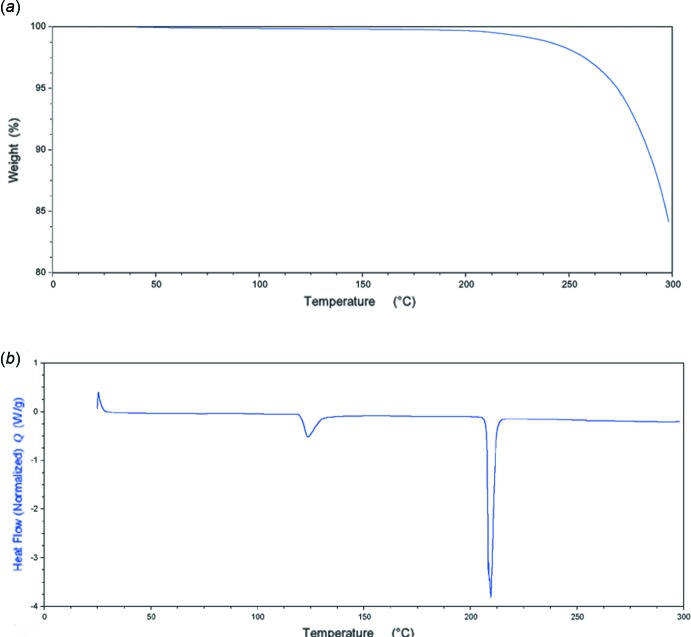
(a) TG curve of (I); (b) DSC curve of (I).